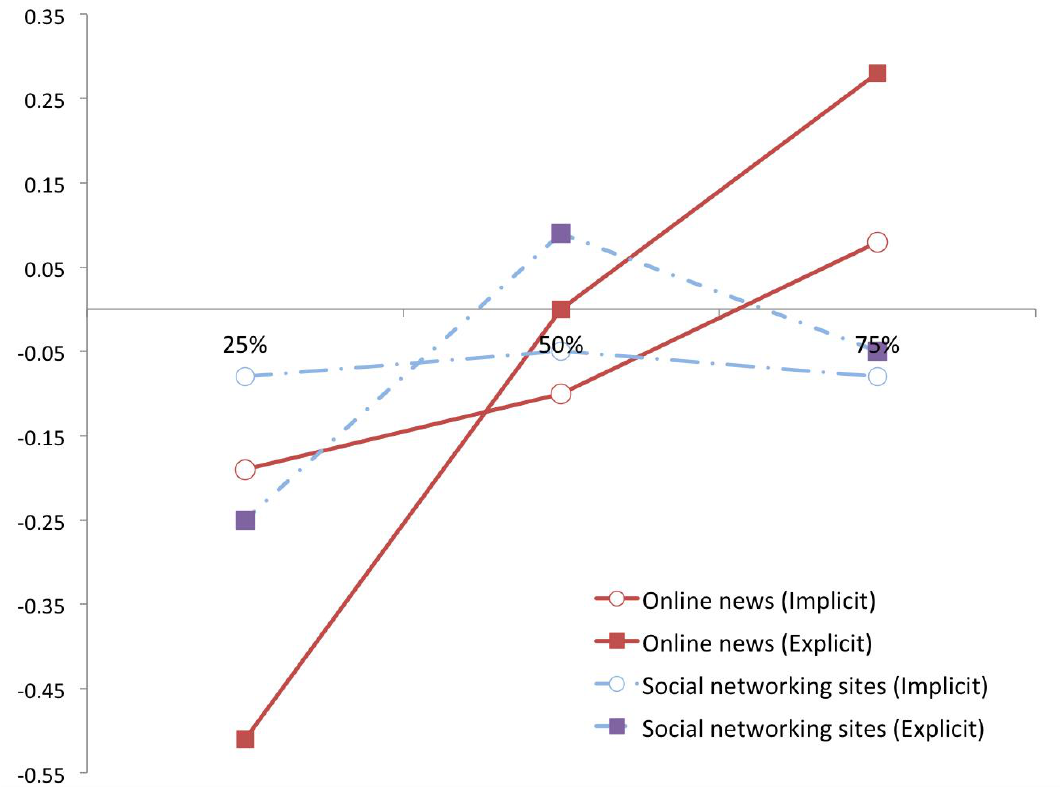
Figure 1: Attitude scores on the y-axis indicate increases in preference for initially chosen candi- date after experimental treatment as a function of the proportion of favorable information and the source media type (online news or social networking